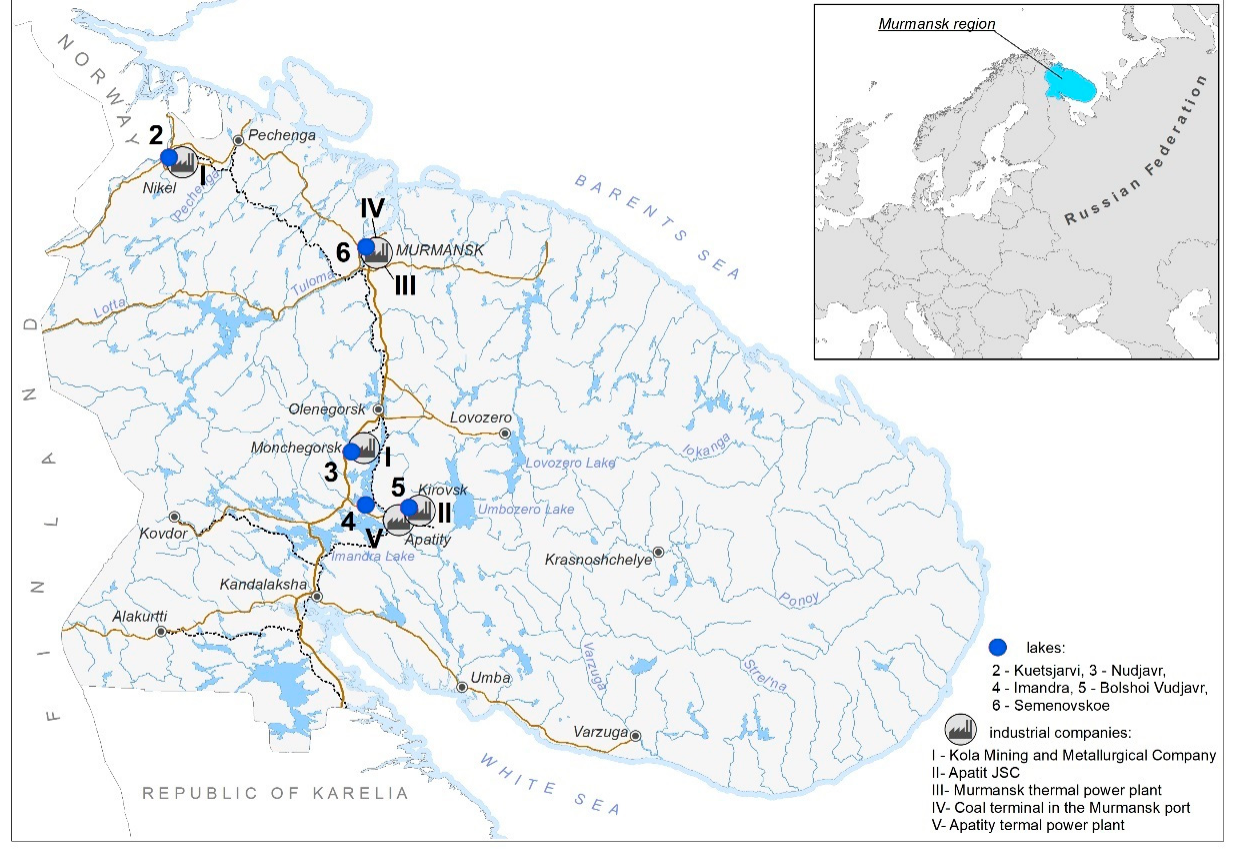
Figure 4. A map of Murmansk region with key lakes, cities, and industrial companies that are noted in the article.